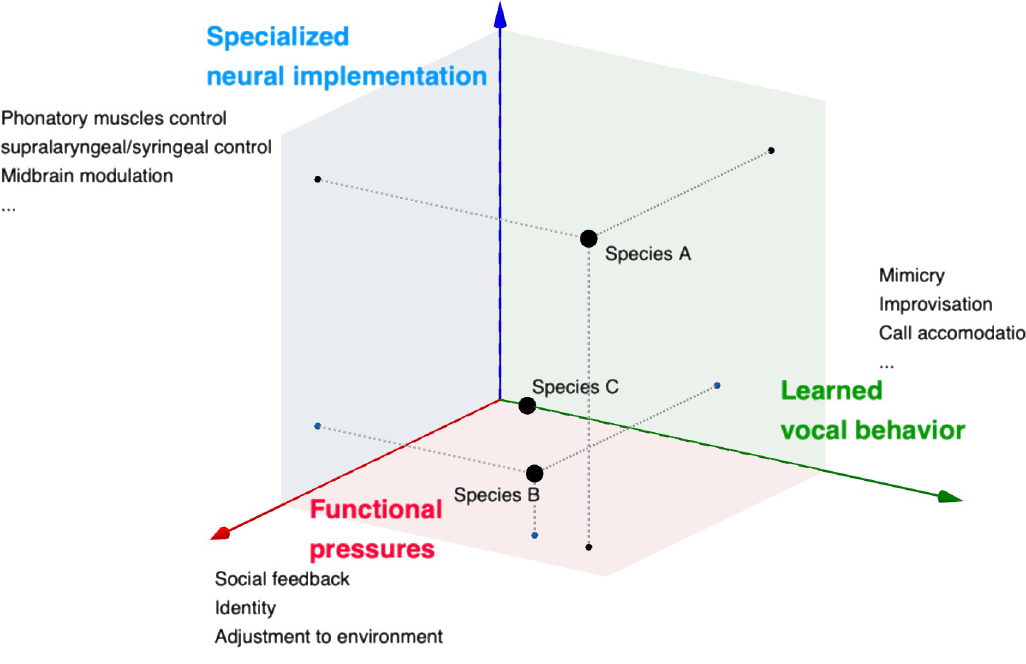
Fig 3. Outline of a vocal learning contiguum. Three main dimensions are considered: learned vocal behavior (green), functional pressures (red), and specialized neural implementation (blue). Examples are given to different factors that can be included in each of these dimensions. Black dots represent hypothetical species placed in the morphospace according to evidence. Species A displays vocal learning abilities and is thought to have a particular neuronal implementation in place, as well as subject to considerable functional pressures that help shape the behavior. Species B is a vocal learner, but evidence for a particular specialized implementation is scarce. For species C, there is no behavioral evidence of vocal learning, and no specialized neural implementation for vocal learning is thought to be present (and concomitantly no functional